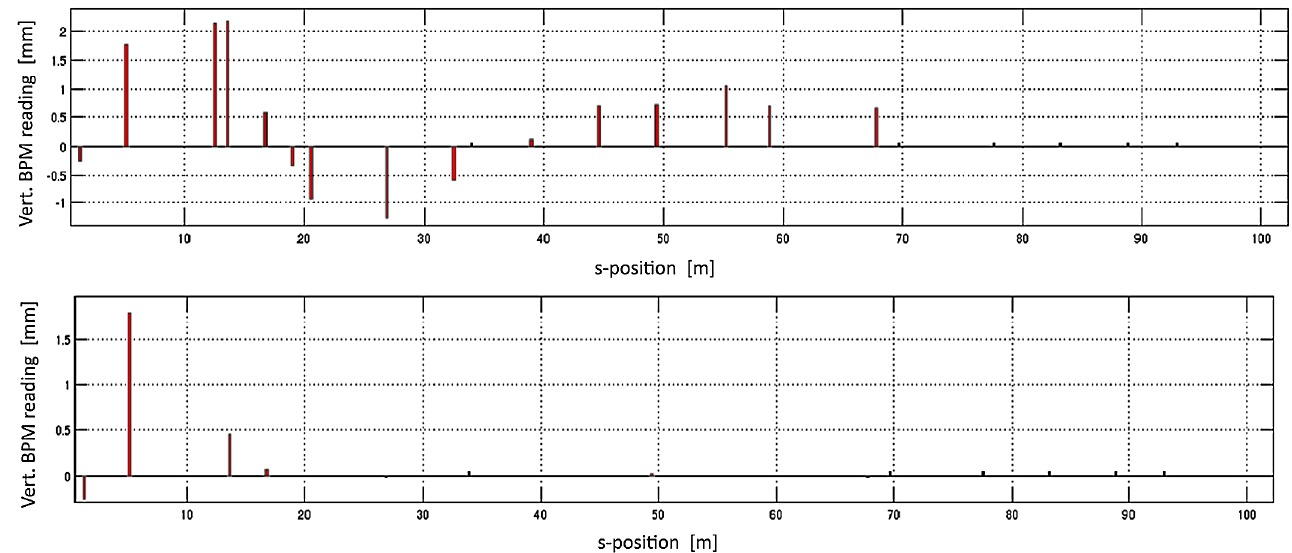
FIG. 9. Vertical trajectory in the FERMI linac, from the LH to the BC1 area, as measured and displayed by the control system. Each bar shows a BPM reading. The top plot is before correction. The bottom plot is after correction (most of BPMs reading have been forced to zero) carried out with the theoretical TRM shown in Fig. 8. The three BPMs with large bars still after correction (left side of the plot) have been excluded from the steering algorithm.